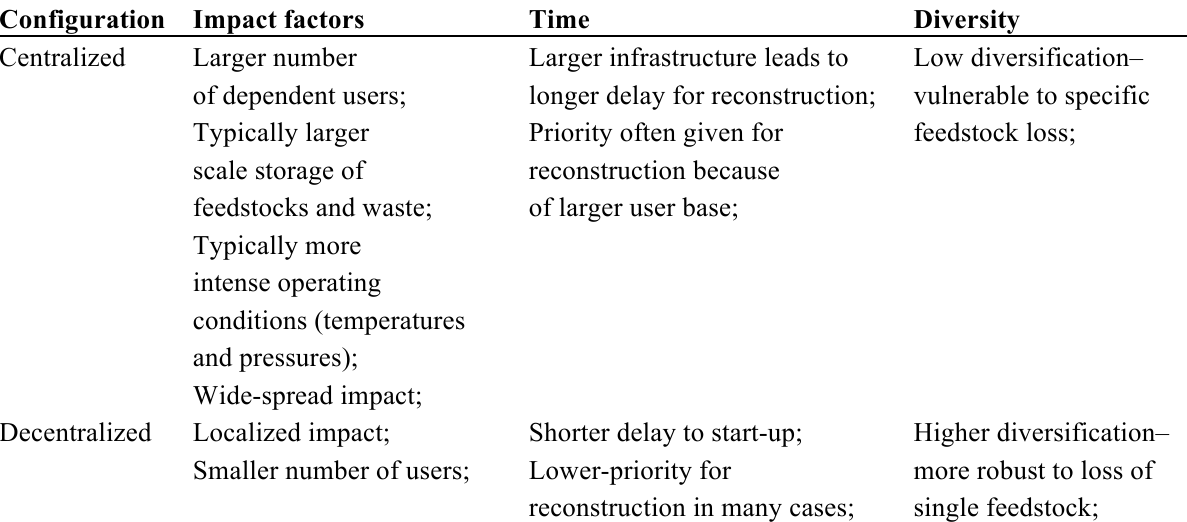
Table 6. Factors affecting risk and vulnerability of centralized or decentralized energy